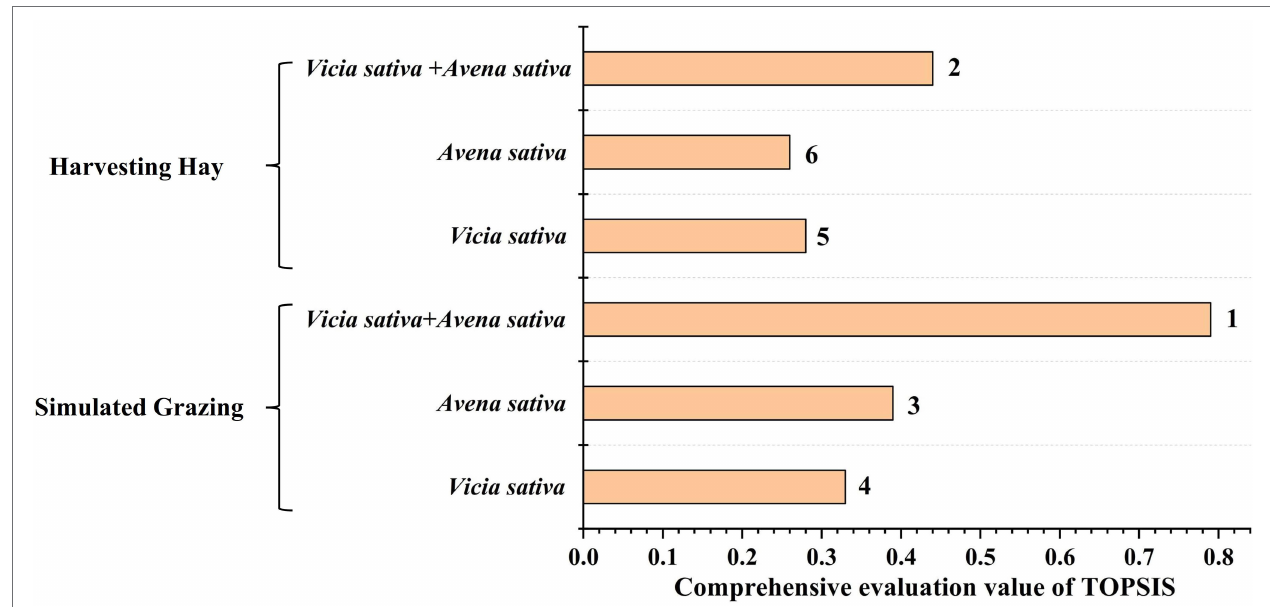
FIGURE 11 | Comprehensive evaluation of cultivated grassland with different sowing varieties (combinations) under simulated grazing (SG) and hay harvesting